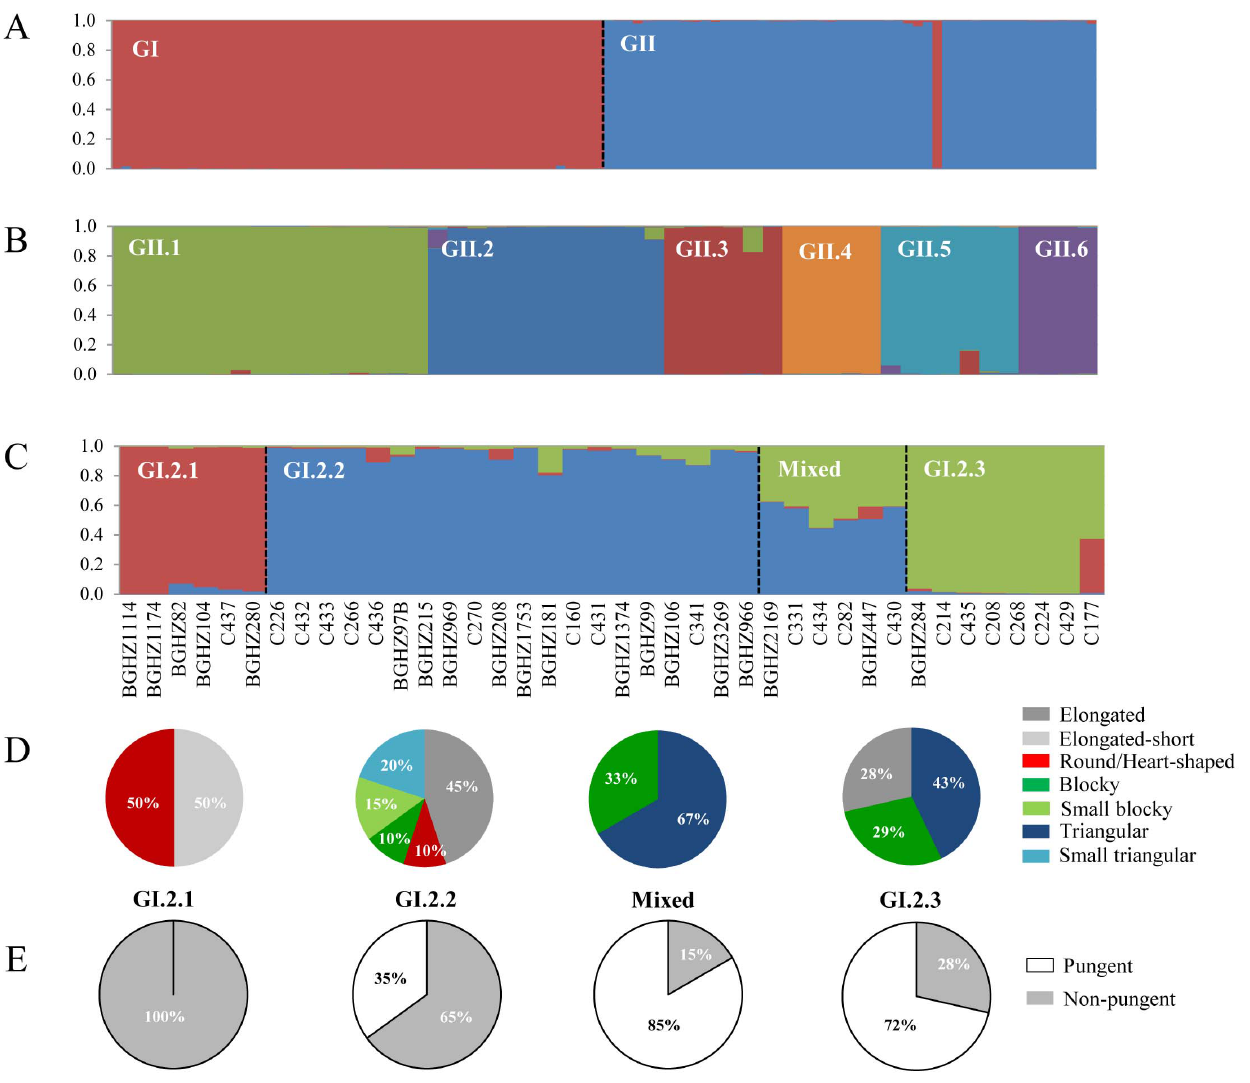
Fig. 3. Bayesian clustering for Capsicum accessions genotyped at 39 loci. A) Structure bar plots based on 102 Capsicum accessions at K 5 2, GI indicates the C. annuum accessions and GII the non- annuum group. B) Structure bar plots based on 50 Capsicum non- annuum accessions at K 5